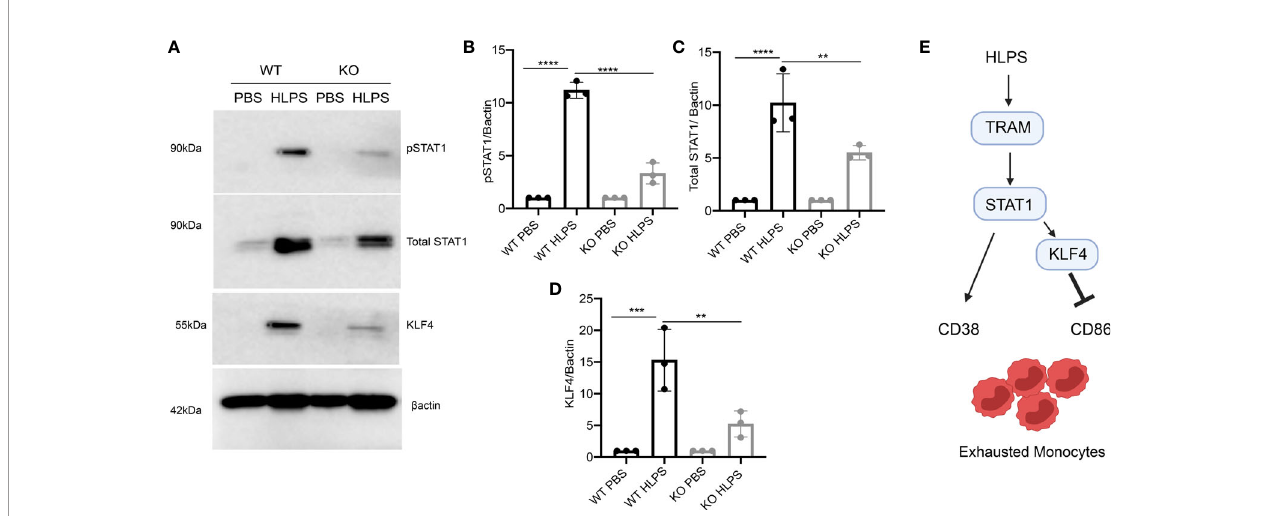
FIGURE 7 | TRAM is required for the activation of STAT1/KLF4 involved in monocyte exhaustion. BMDMs from WT and TRAM KO mice were stimulated with PBS or high dose LPS (100 ng/mL) for 5 days. (A) The levels of pSTAT1, total STAT1 and KLF4 were determined by Western blot. (B – D) The relative levels of pSTAT1 (B) , STAT1 (C) and KLF4 (D) were normalized to b -actin. (E) Schematic illustration summarizing potential mechanism involved in monocyte exhaustion. The data are representative of at least three independent experiments, and error bars represent means ± SEM (n=3 for each group) **p < 0.01, ***p < 0.001, ****p < 0.0001, one- way